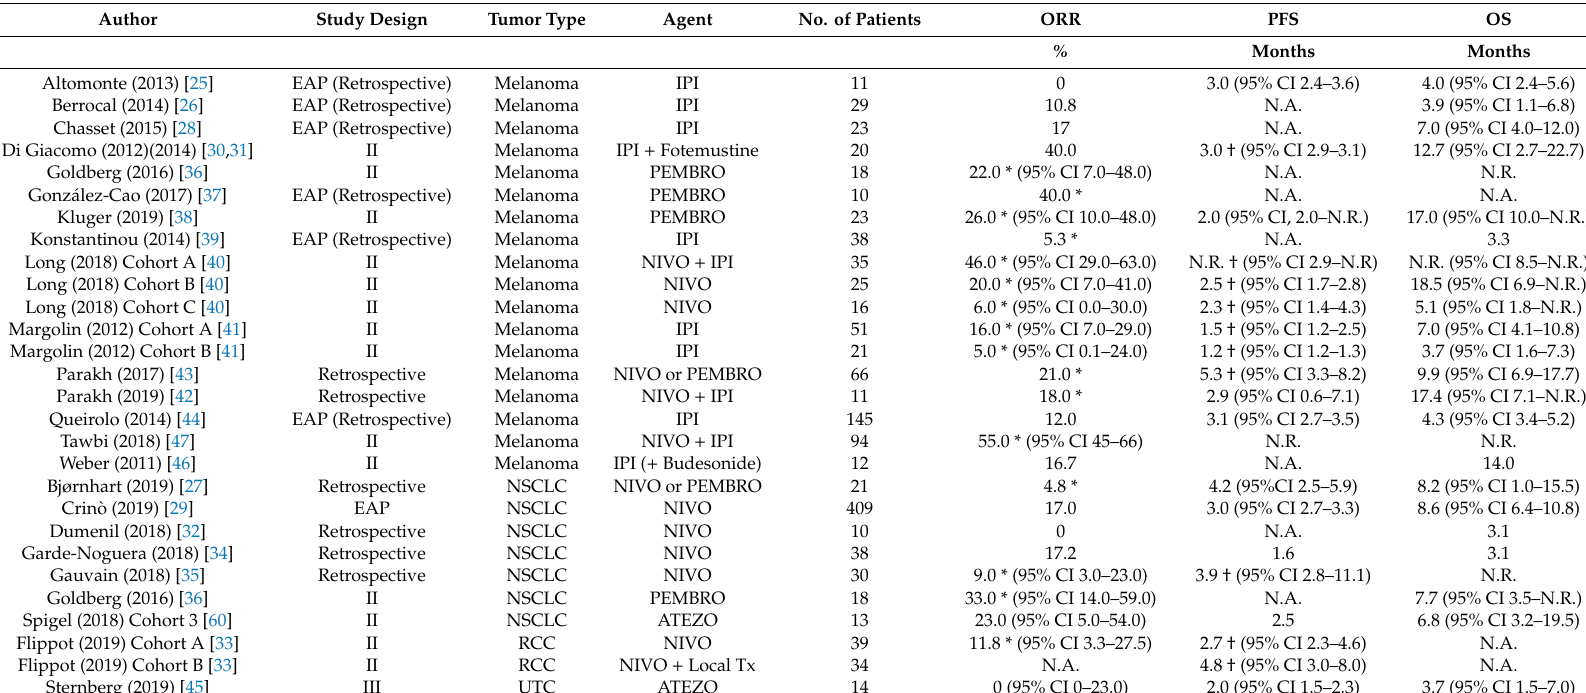
Table 2. Primary outcomes of clinical studies with immune checkpoint inhibitors in patients with brain